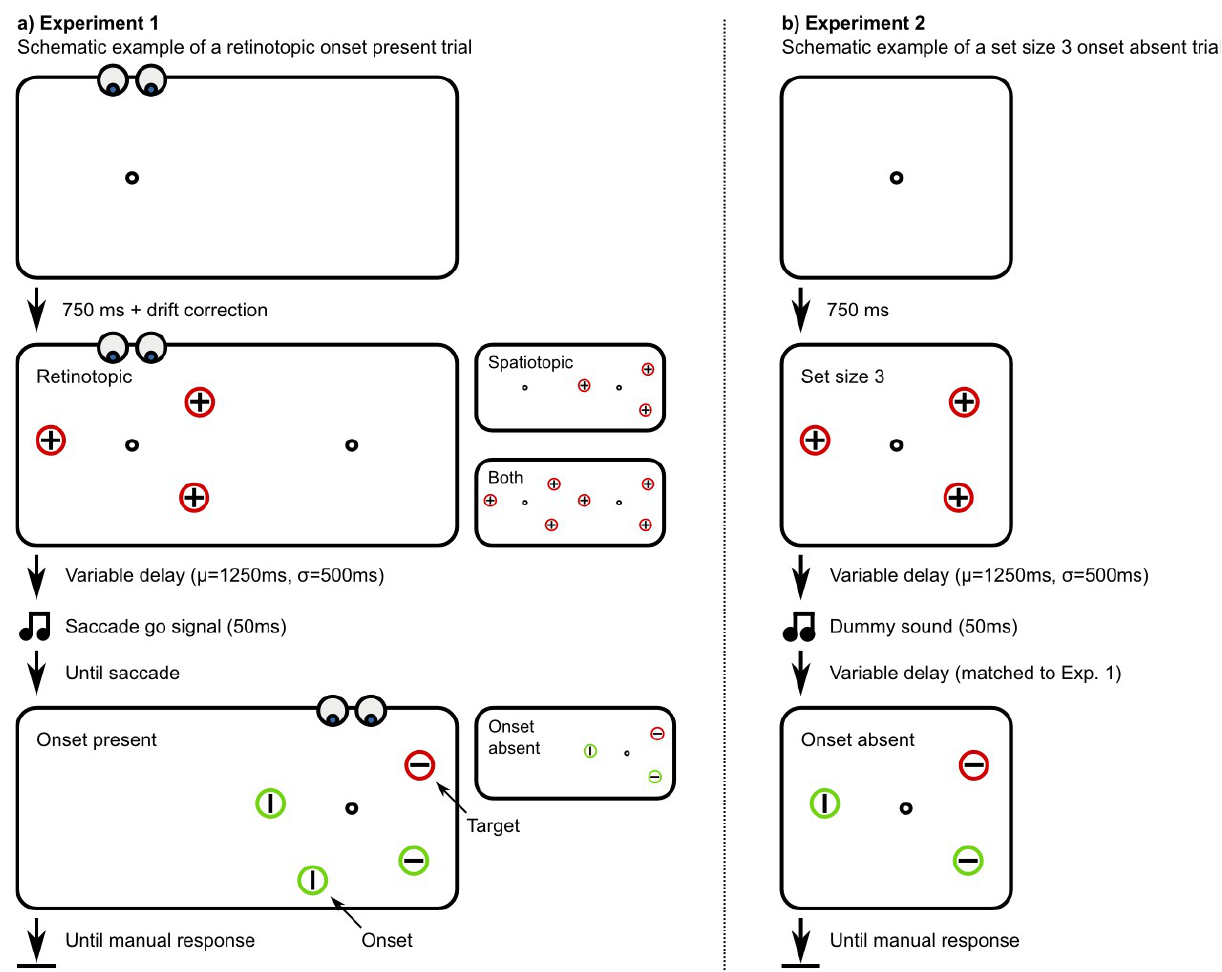
Figure 1. a) A schematic example trial of Experiment 1 in the retinotopic, onset present condition. The target is defined as the line- segment in the uniquely coloured circle. The abrupt onset appears at a previously unoccupied location, either in retinotopic coordinates (eye centred; as shown here), spatiototopic coordinates (world centred), or both. b) A schematic example trial of Experiment 2 in the set size 3, onset absent